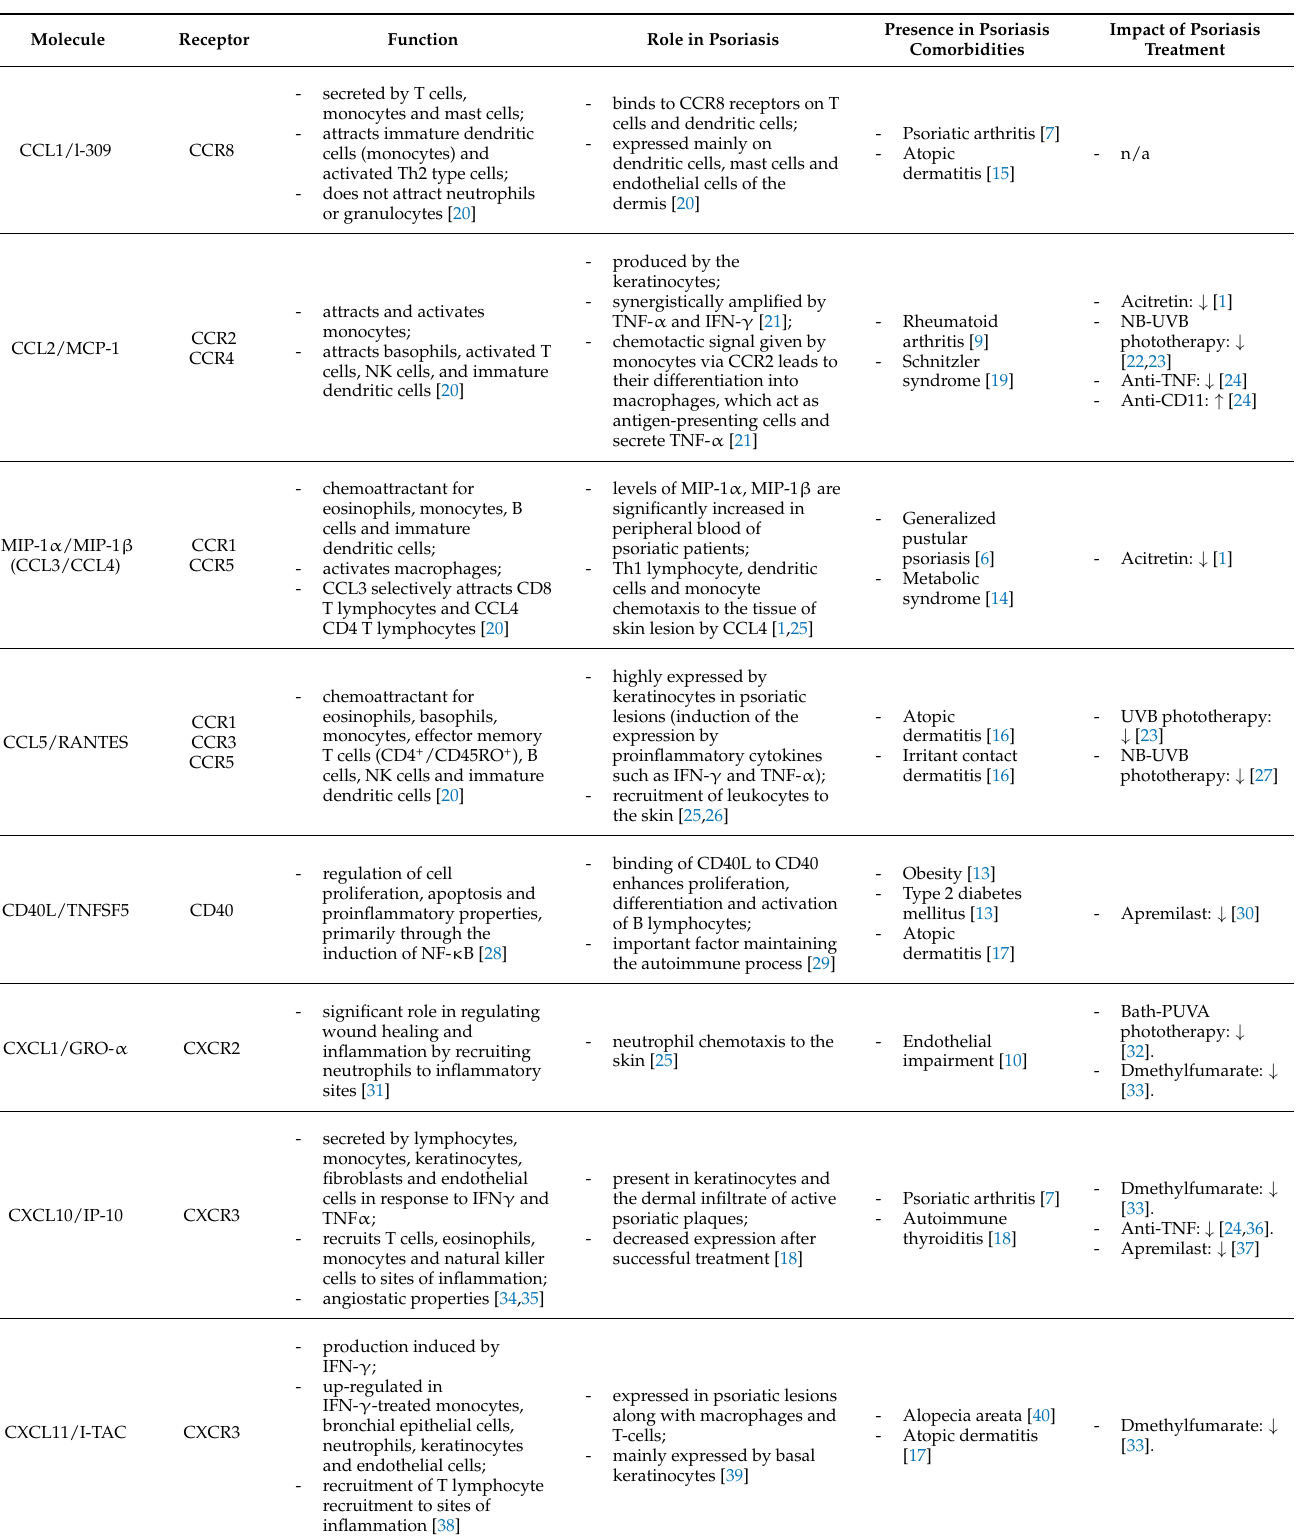
Table 1. Role and function of selected chemokines in